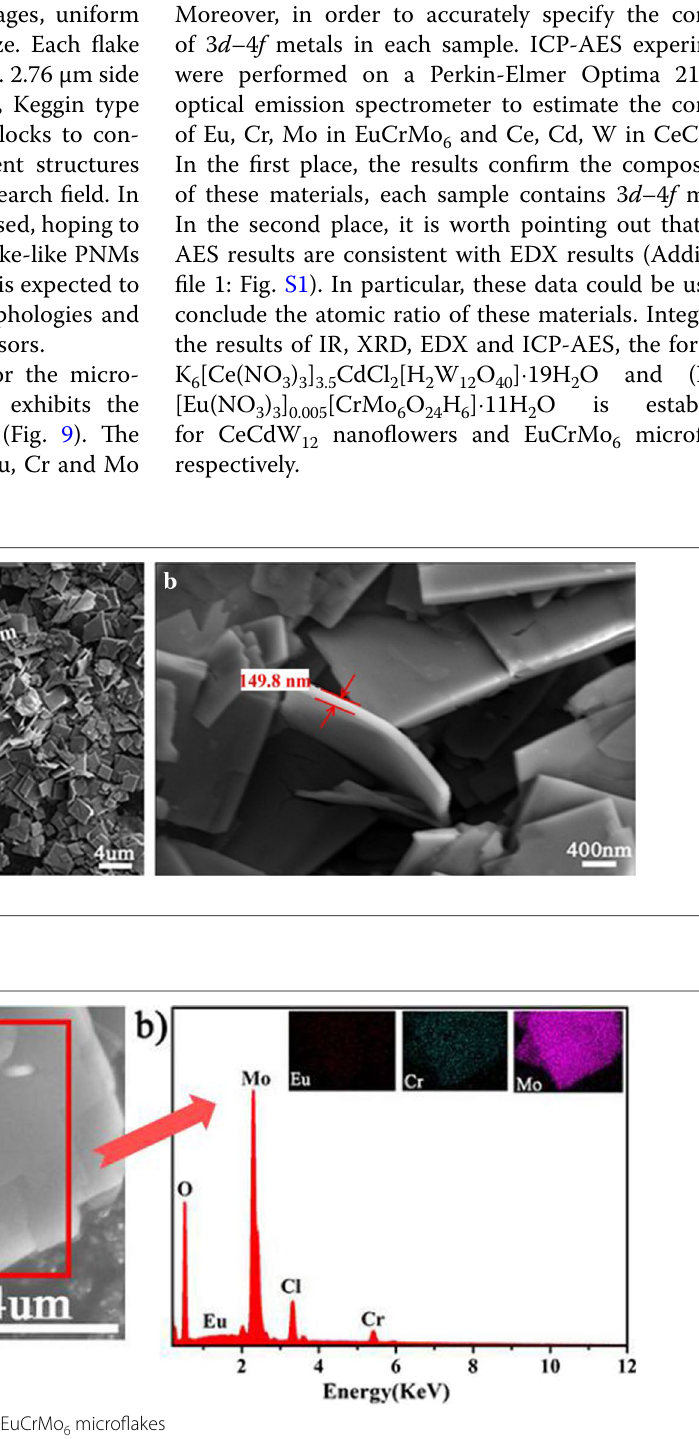
Fig. 9 Corresponding element mappings and EDX of EuCrMo 6